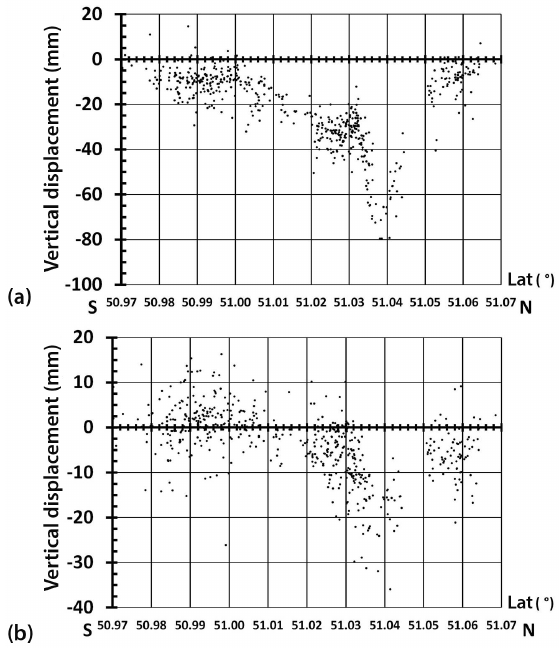
Figure 4. Variation of the total surface movement along a north– south transect, situated for a longitude between 5.37 and 5.38 ◦ E: (a) period 1, 5-year time zone, from mid-August 1992 through mid- August 1997; (b) period 1, 2.5-year time zone, from July 1998 through December